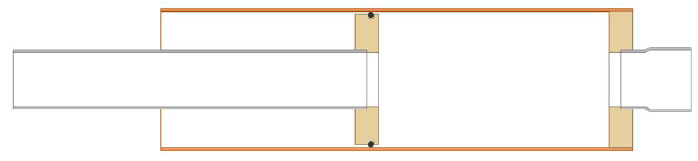
Figure 14. Cross section showing an example of the expansion chamber structure.